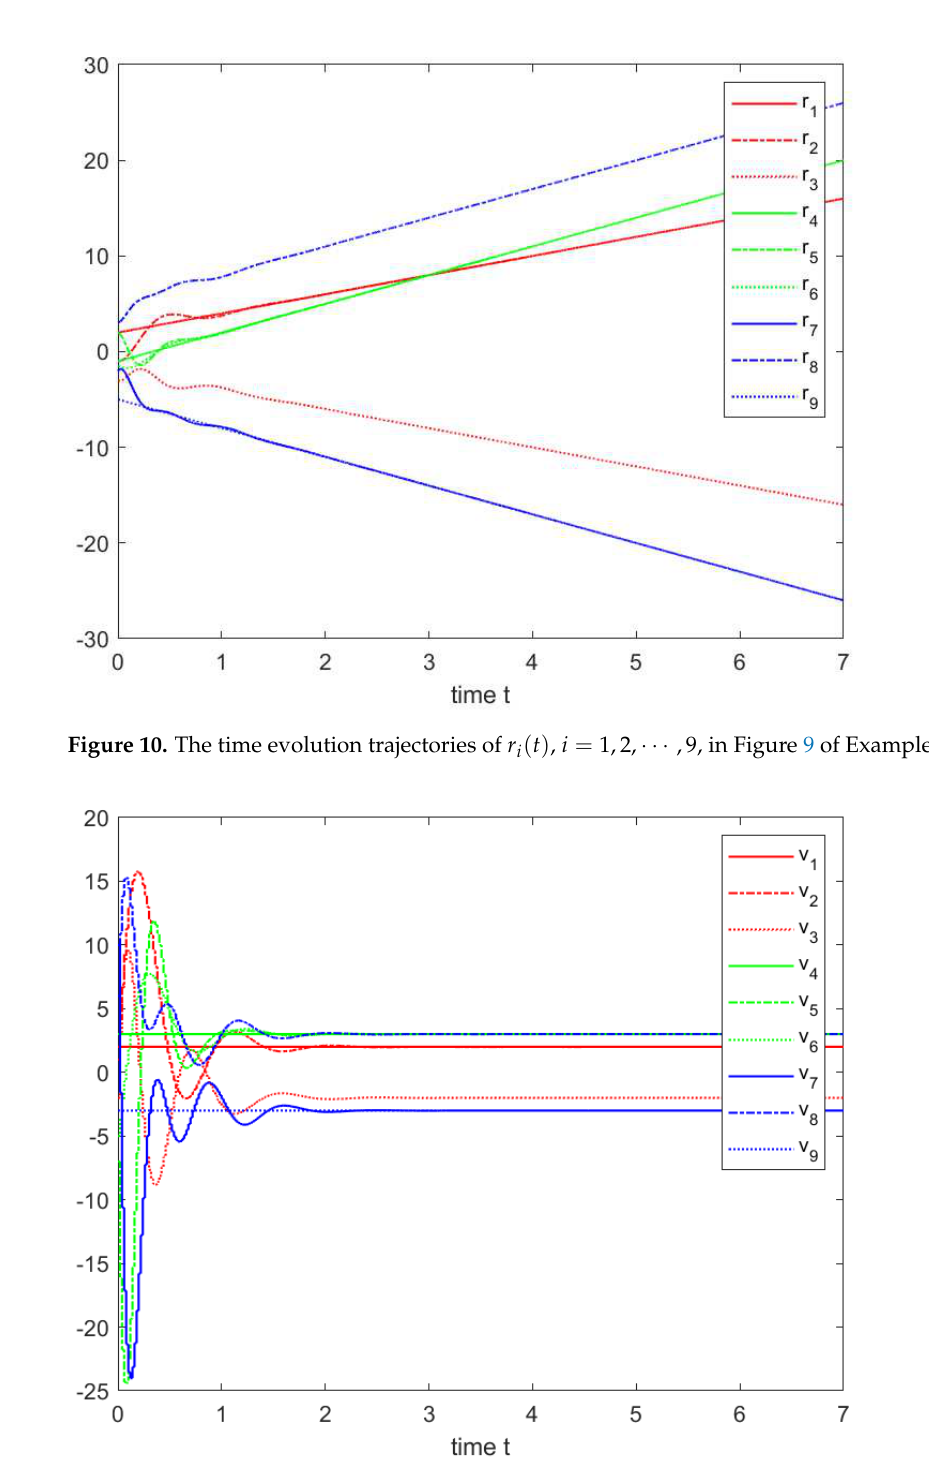
Figure 11. The time evolution trajectories of r i ( t ) , i = 1,2, · · · ,9, in Figure 9 of Example